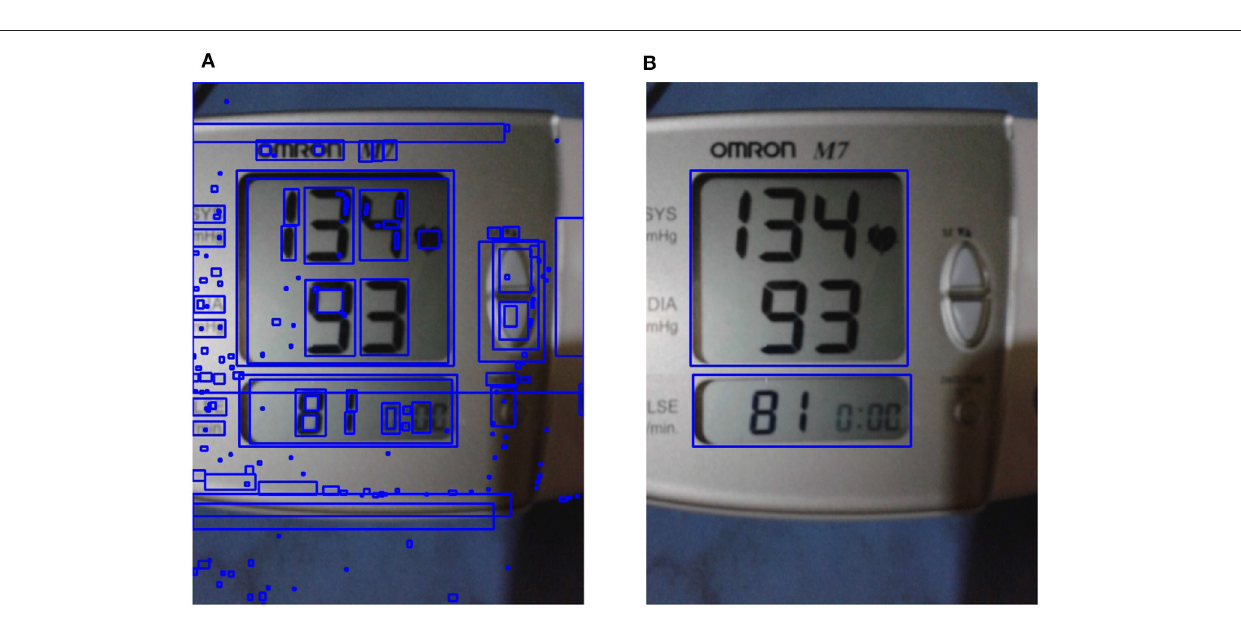
monitor. Hence, the authors normalized each of the frames to a fixed size using scaling. The bounding boxes extracted from the images included the boundary of the LCD. A simple approach to discard these boundaries by removing certain rows and columns along the boundary of the normalized LCD images was adopted. The row and column removal thresholds were decided through